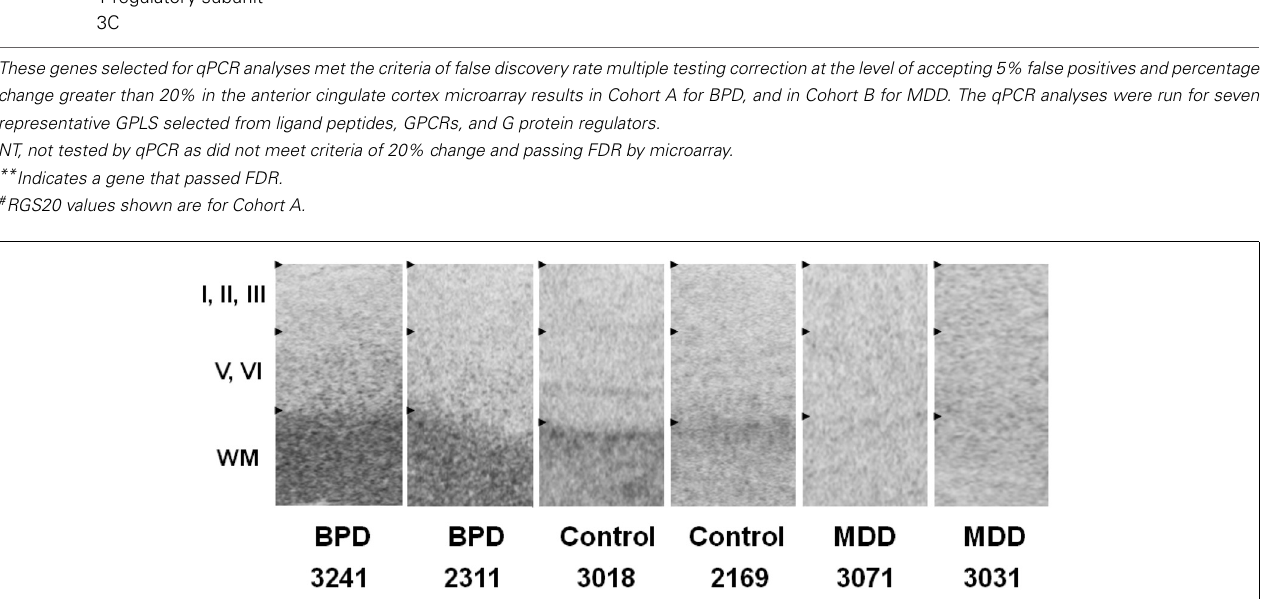
(I–III). Expression levels in GPR37 is increased in the BPD subjects, and decreased in MDD subjects in subcortical white matter in anterior cingulate cortex tissue, compared to control subjects. WM, Subcortical white matter; BPD, Bipolar disorder; MDD, Major depressive